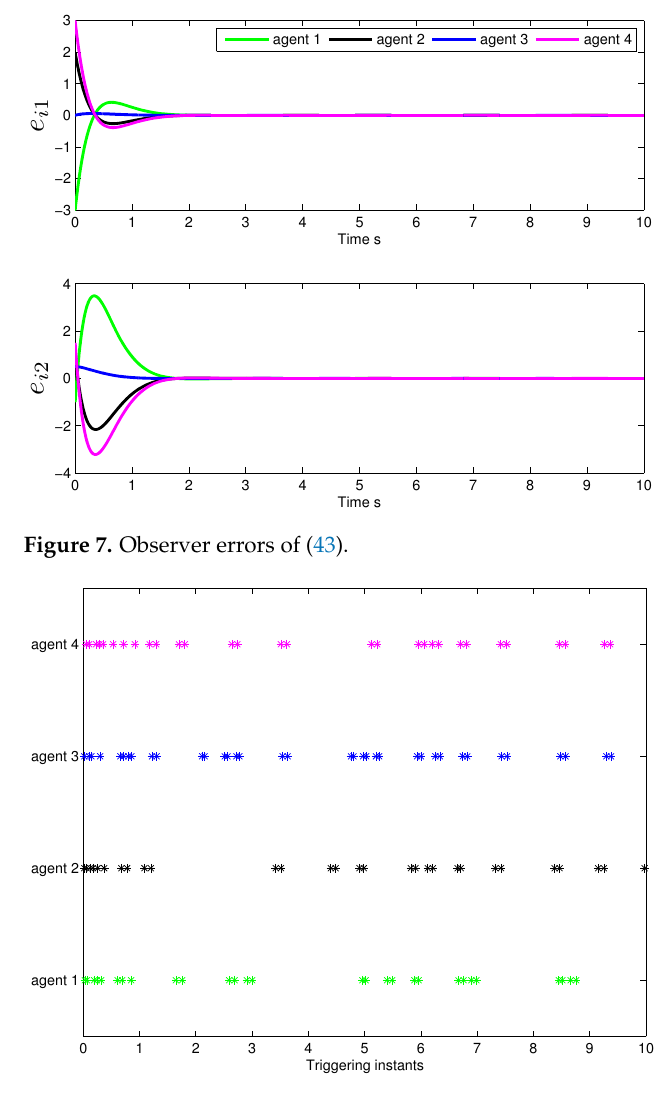
Figure 8. Triggering instants of MAS (42) with observer-based